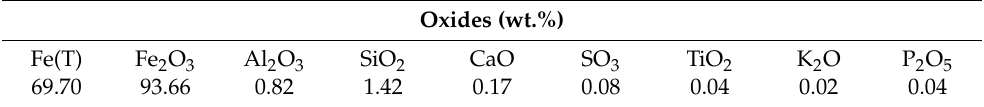
Figure 1. XRD pattern of mill scale used in the present study. Table 2. Chemical composition of the mill scale used in the present study.